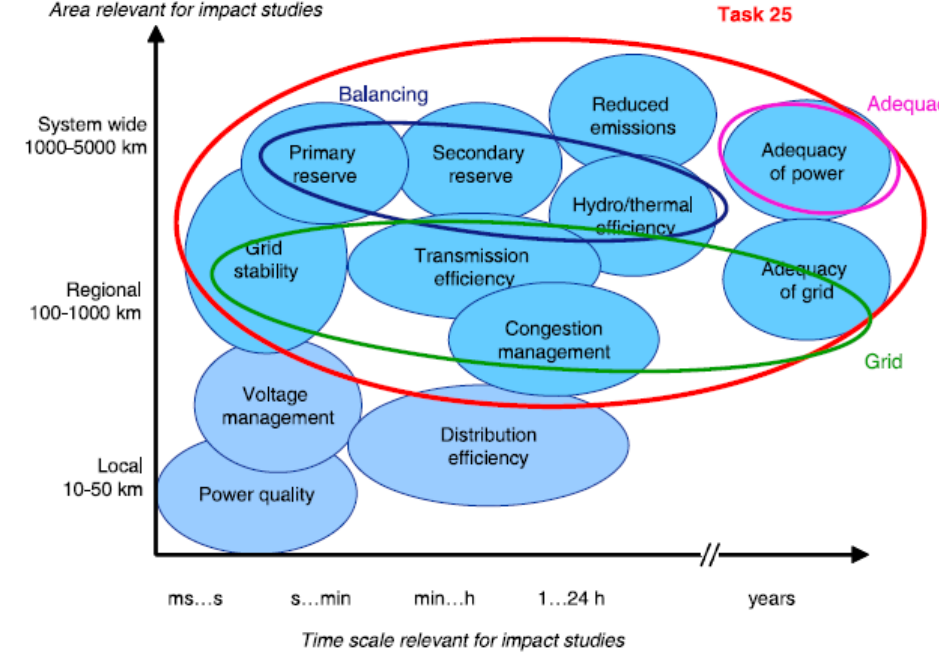
Figure 49. Typology of grid impacts of wind power across temporal and spatial scales (© 2008 IOP, reproduced with permission from [204]). Balancing reserves deal with short-term variability in the order of up to 24 h. Adequacy in peak-load situations ( i.e. , low LOLE) has to be secured long-term and requires load-carrying reserves to compensate for shortfalls in capacity